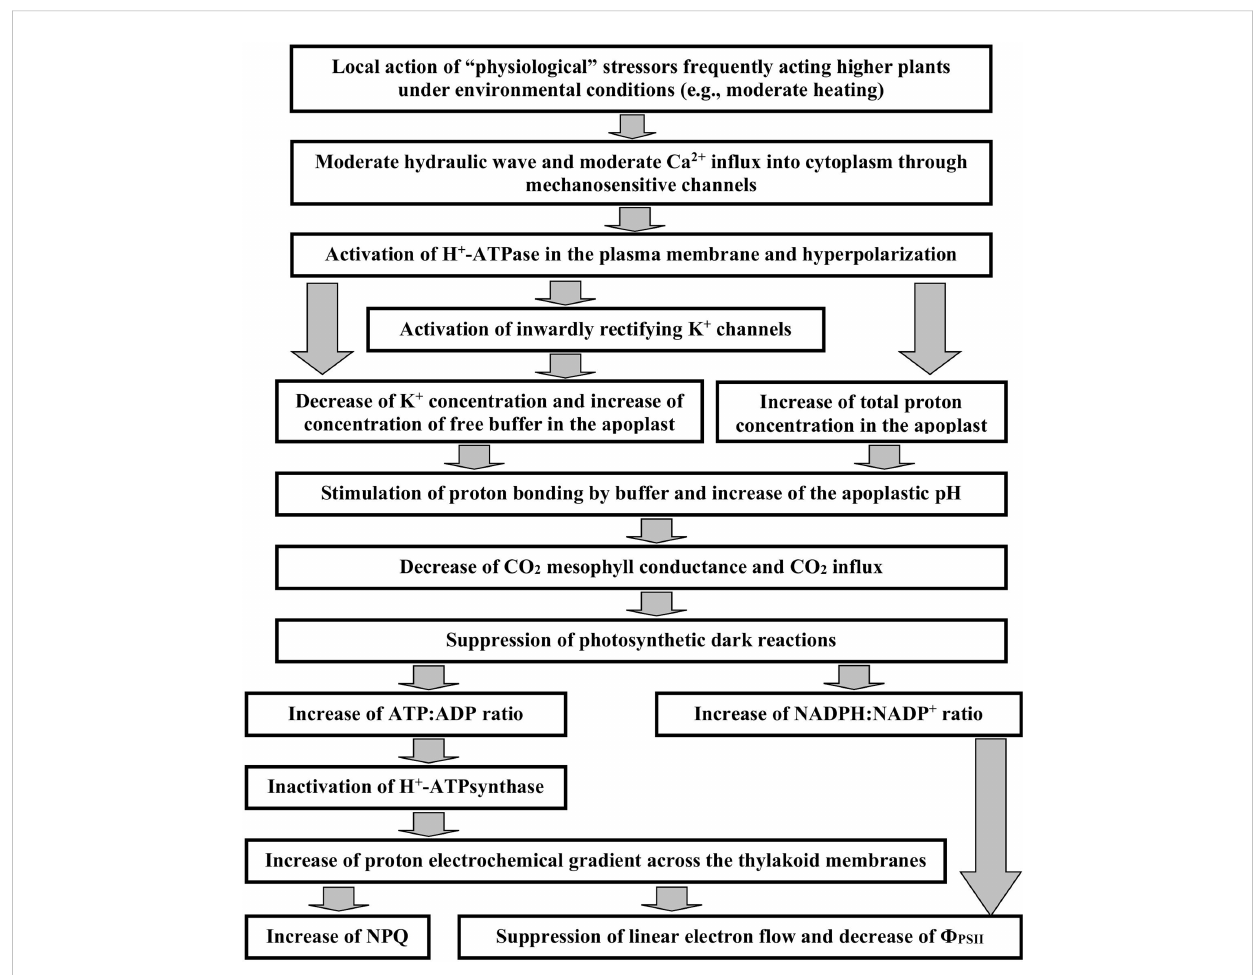
FIGURE 15 A scheme of hypothetical ways of in fl uence of hyperpolarization electrical signals (system potentials) on photosynthetic processes (see Discussion for details). The scheme is based on results of the current work and our previous results summarizing in reviews (Sukhov, 2016; Sukhov et al., 2019; Sukhova and Sukhov,